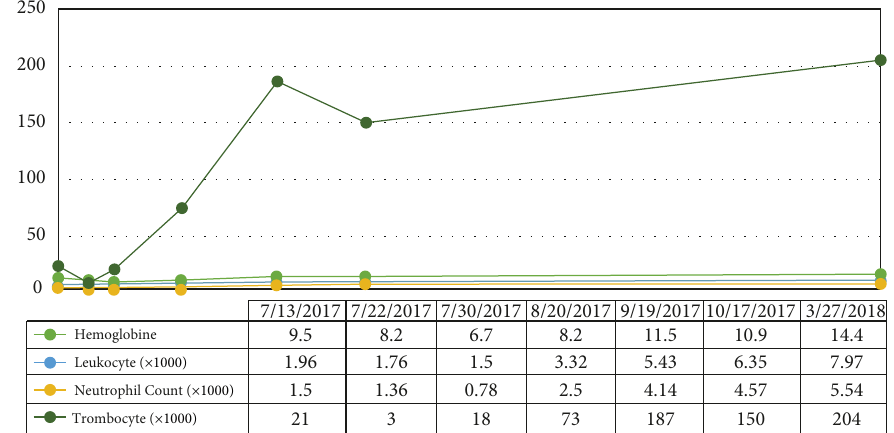
Figure 4: Improvement in peripheral blood parameters following treatment with an antifungal in case 1.